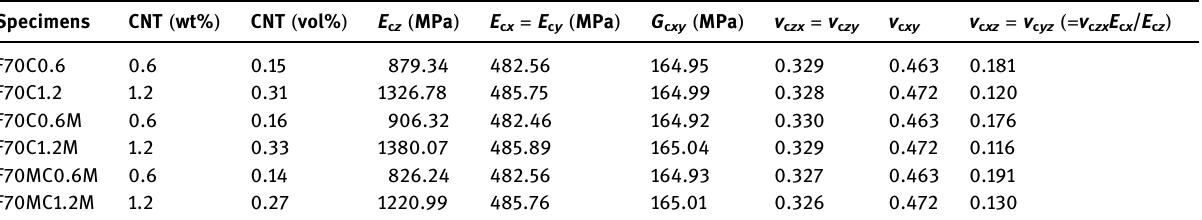
Table 4: Material properties of long CNT RVEs extracted from the FE model